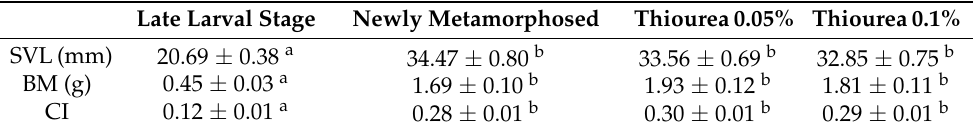
Table 1. The total snout-vent length (SVL), body mass (BM), and body condition index (CI) of late larval stage (62 stage), newly metamorphosed, and metamorphosis-arrested (after exposure to low (0.05%) and high (0.1%) thiourea concentrations) crested newts. SVL and BM are given as the mean ± SE, the CI was calculated on log-transformed data. The letters a and b show the results of statistical analysis (Tukey HSD, p < 0.05). The same letter indicated that the difference between the groups was not significant. Different letters indicated that they were significantly